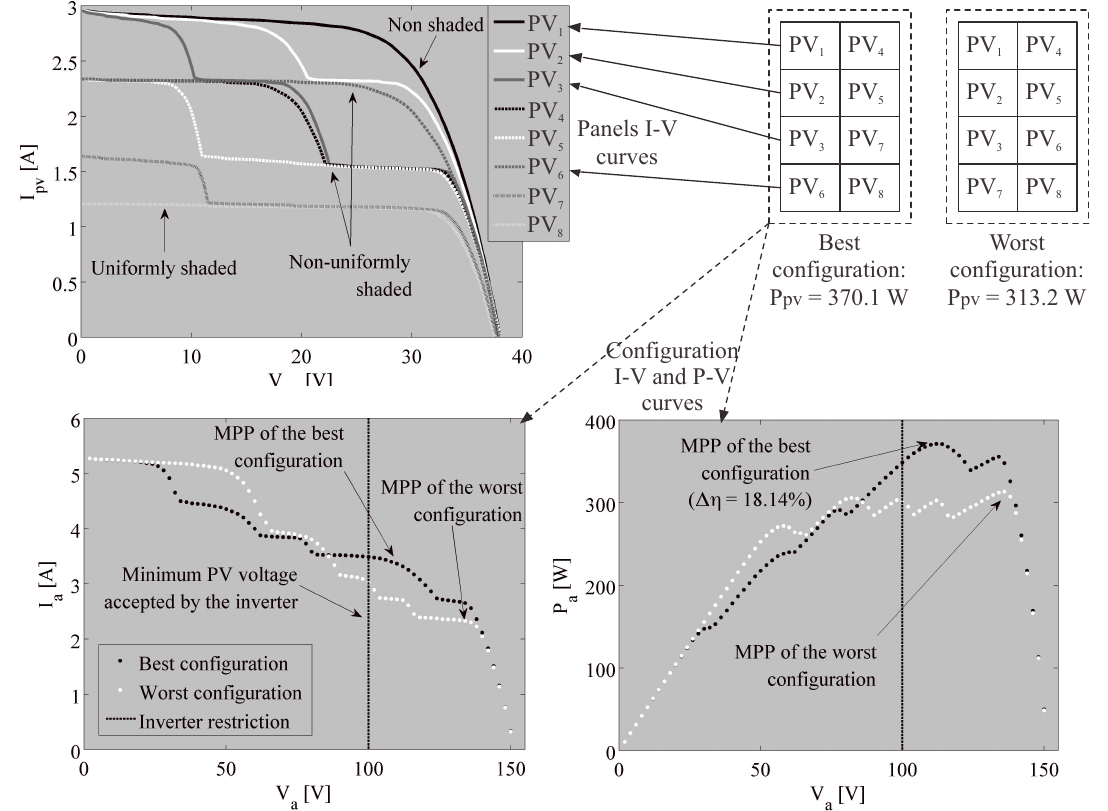
Figure 7. Best and worst configurations for the application